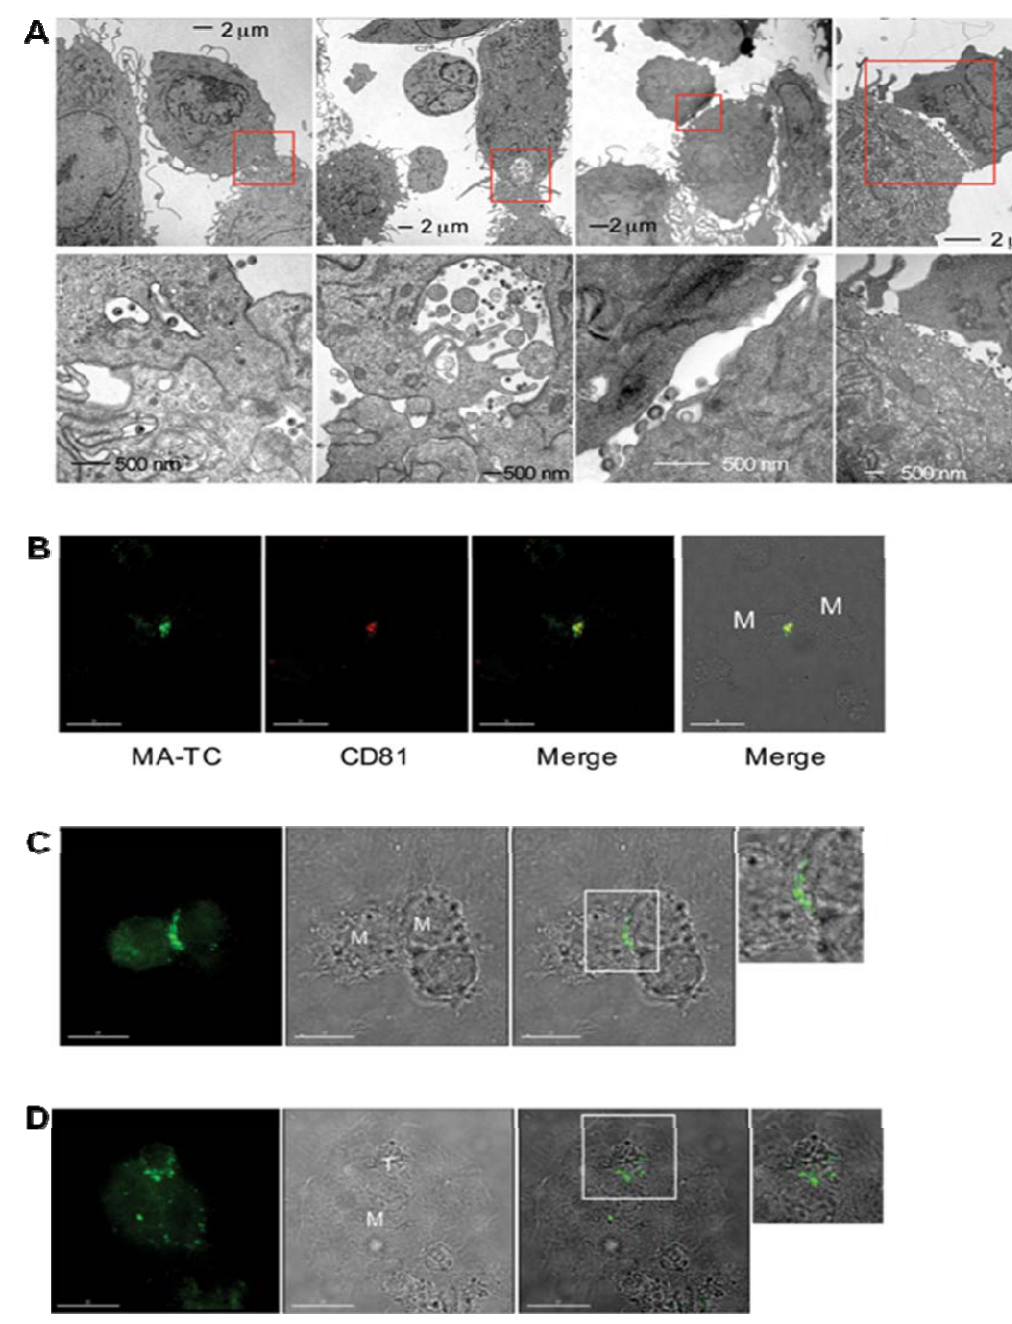
that T-cells often extend pseudopod or uropod-like extensions that contact the infected MDM at the VS; the signals that induce the formation of these T-cell extensions remain to be defined. Figure 3. Recruitment and accumulation of Gag at the MDM/MDM and MDM/T-cell synapse. Cells were infected with a tetra-Cys-tagged HIV-1 clone (A, B) or an Env(-) derivative (C, D) . EM images show the accumulation of virions in intracellular compartments near the plasma membrane and the contact sites between infected MDM and uninfected MDM (A) . Gag and the tetraspanin CD81 are recruited to the MDM/MDM contact site (B) . Gag in infected MDMs is relocated to the contact sites with both uninfected MDMs (C) and Jurkat T cells (D) in the absence of Env expression. Scale bars, 30  m (B) and 15  m (C) and (D) . From Gousset et al. 2008